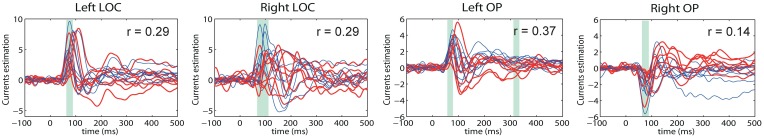
MNE estimated timeseries for MNE defined ROI. Red lines—timeseries for 8 subjects in “face” condition; blue lines— timeseries for 8 subjects in “scrambled” condition. The cyan shadow stripes mark time intervals with duration greater than 20 ms and with values of t-statistics corresponding to 0.05 significance level of uncorrected t-test. No time intervals with pcorrected(t < 0.05) were found. We used t-statistics here to quantify the observed distance between conditions and by no means as a statistical test aimed at finding intervals of significant differences. Mean across subject correlation coefficients for each ROI are shown. Note, that ROIs selected based on the MNE solution give rise to quite different activations of the symmetric cortical regions. LOC, lateral occipital complex; OP, occipital pole.